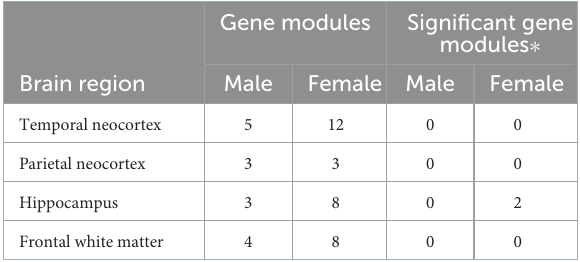
TABLE 2 Number of gene modules identified using weighted co-expression network analyses and significant gene modules based on module-trait relationships with dementia status using TBI-associated differentially expressed genes stratified by sex and brain